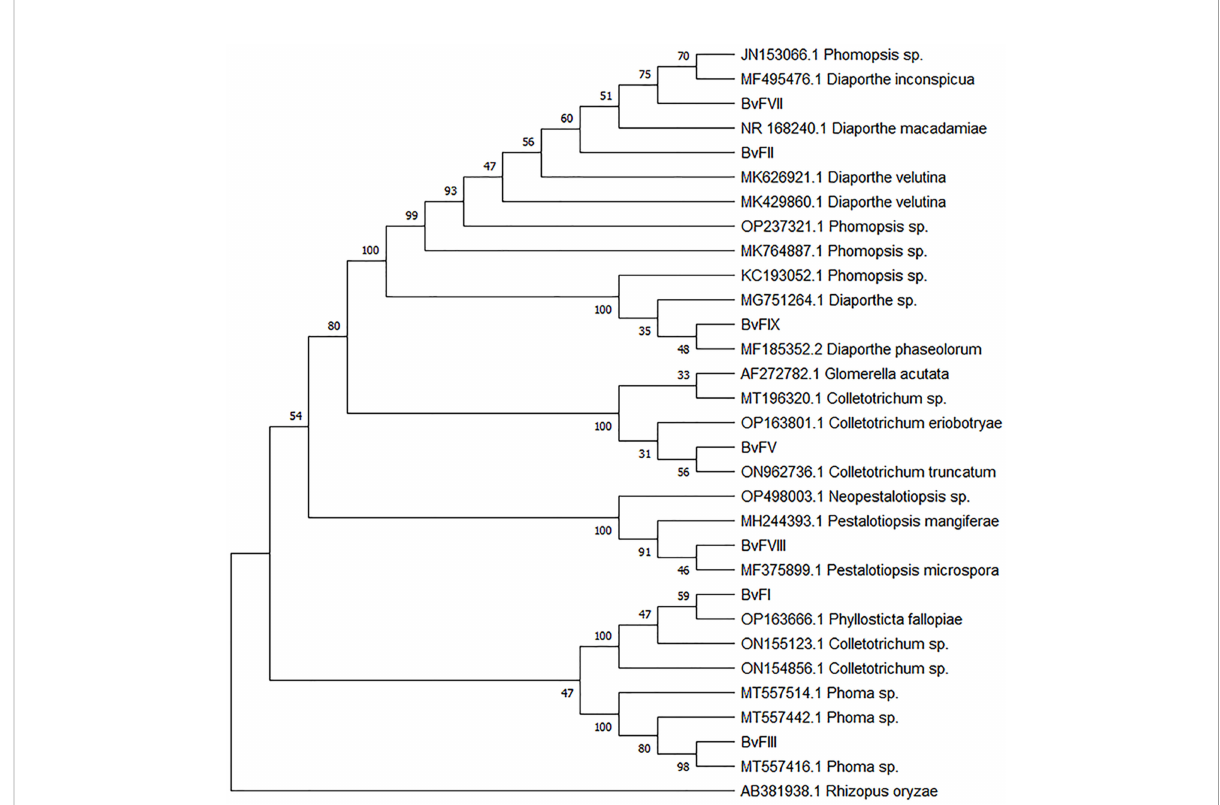
FIGURE 1 Phylogenetic tree constructed for PCR amplicons of the ITS1-5.8S-ITS2 rDNA of the endophytic fungi by genetic similarity comparison with data acquired with data from GenBank (NCBI). Phylogenetic tree constructed on the basis of the similarity of the PCR amplicons of the internal transcribed spacer 1 and 2 rDNA regions and sequences found in GenBank (NCBI), analyzed by the grouping neighbor-joining method, with 1,000 bootstrapping repetitions. The number of rami fi cations presents the bootstrap value (Felsenstein, 1985). The analysis involved 31 FASTA sequences. Rhizopus oryzae was used to root the phylogenetic tree. All positions containing gaps and missing data were eliminated. Evolutionary analyses were conducted in MEGA11 (Tamura et al.,